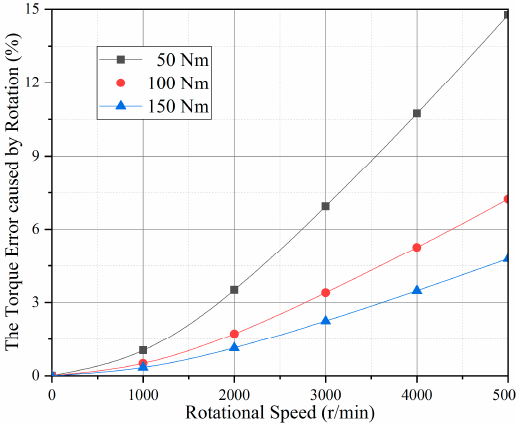
Figure 3. The torque calculation error caused by rotation.